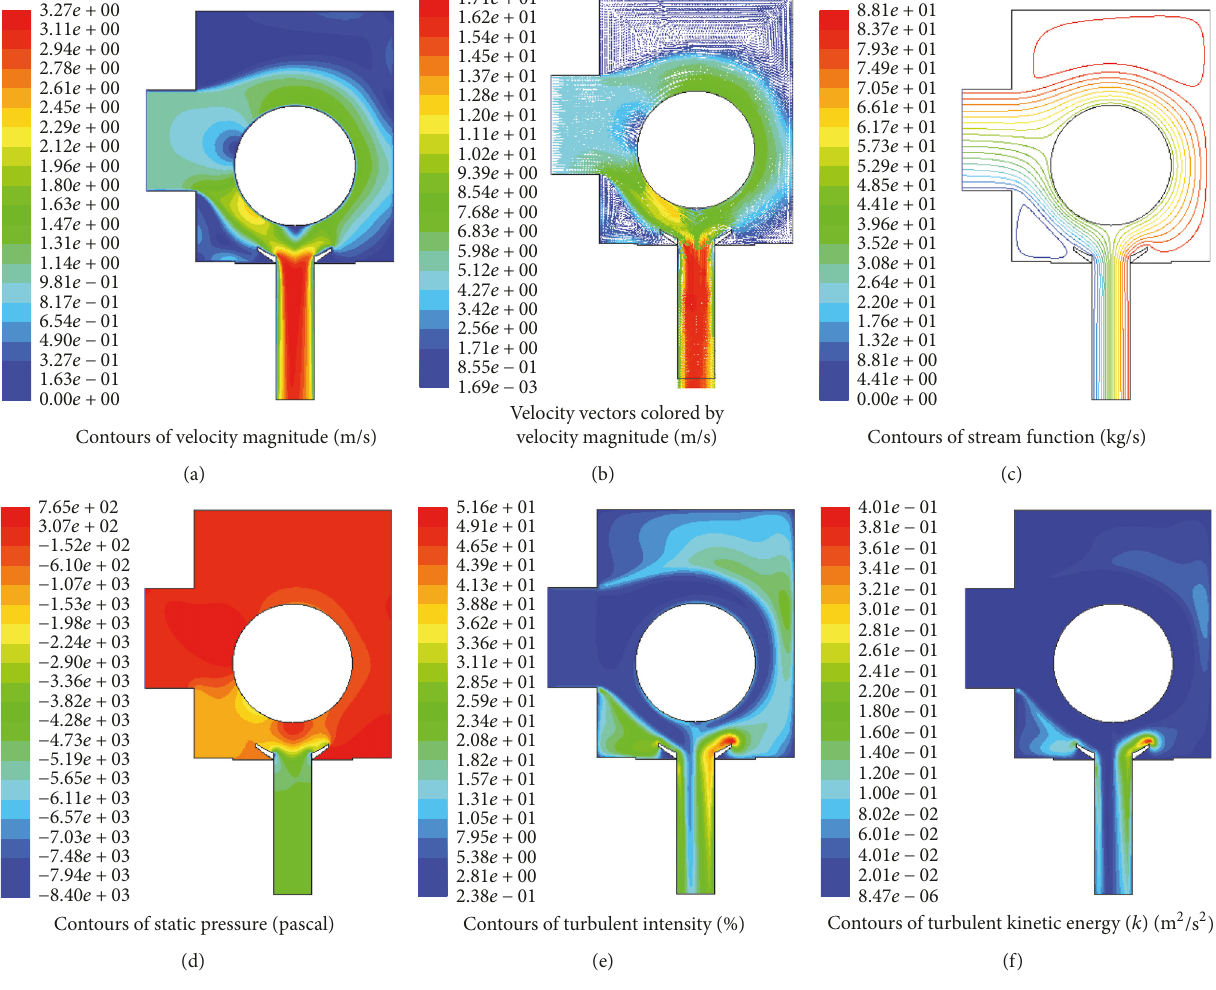
Figure 5: (a) Contours of velocity magnitude; (b) contours of velocity vector; (c) contours of stream function; (d) contours of static pressure; (e) contours of turbulent intensity; (f) contours of turbulent kinetic energy in drainage device at T3